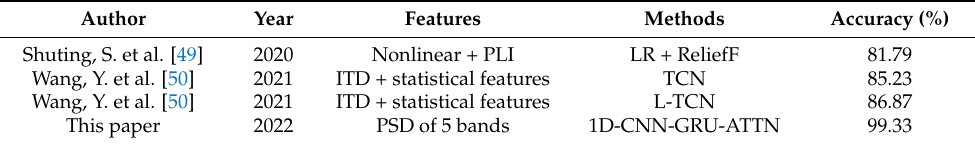
Table 9. The comparison of the classification results between the proposed method and previous works.